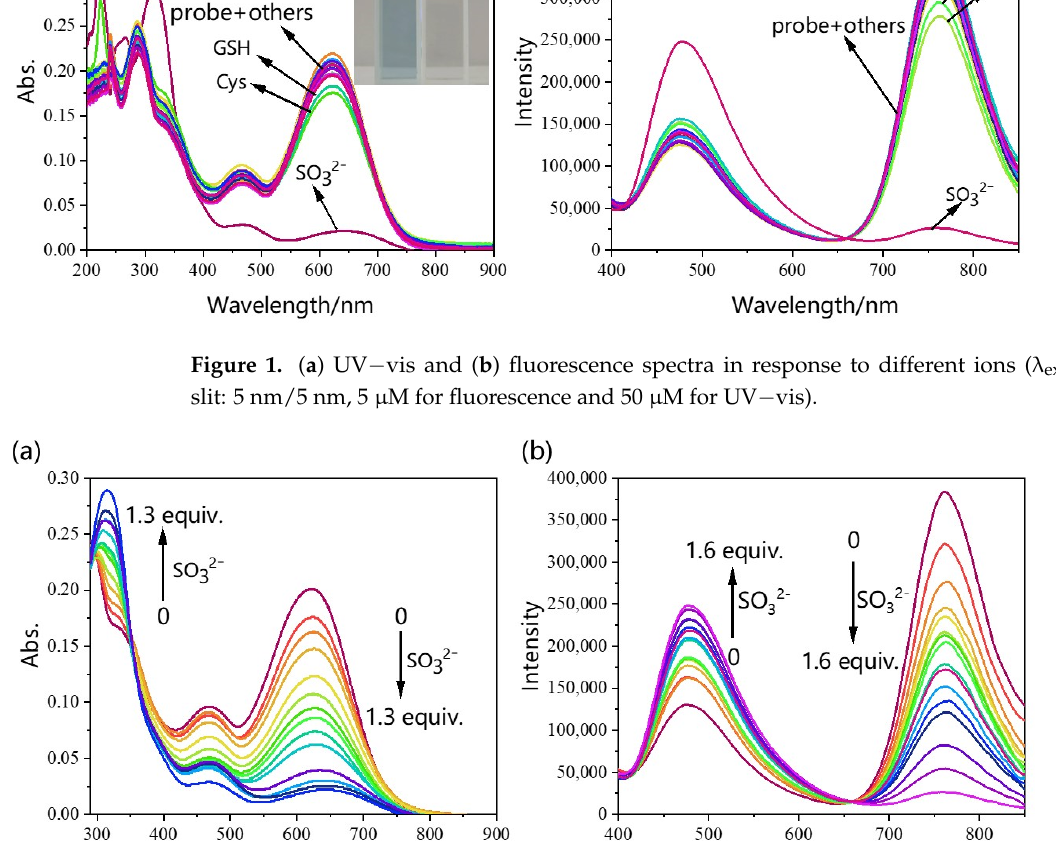
Figure 2. ( a ) UV − vis and ( b ) fluorescence spectra of IPB-RL-1 upon the addition of SO 32 − ( λ ex = 300 nm, slit: 5 nm/5 nm, 5 µ M for fluorescence and 50 µ M for UV − vis).